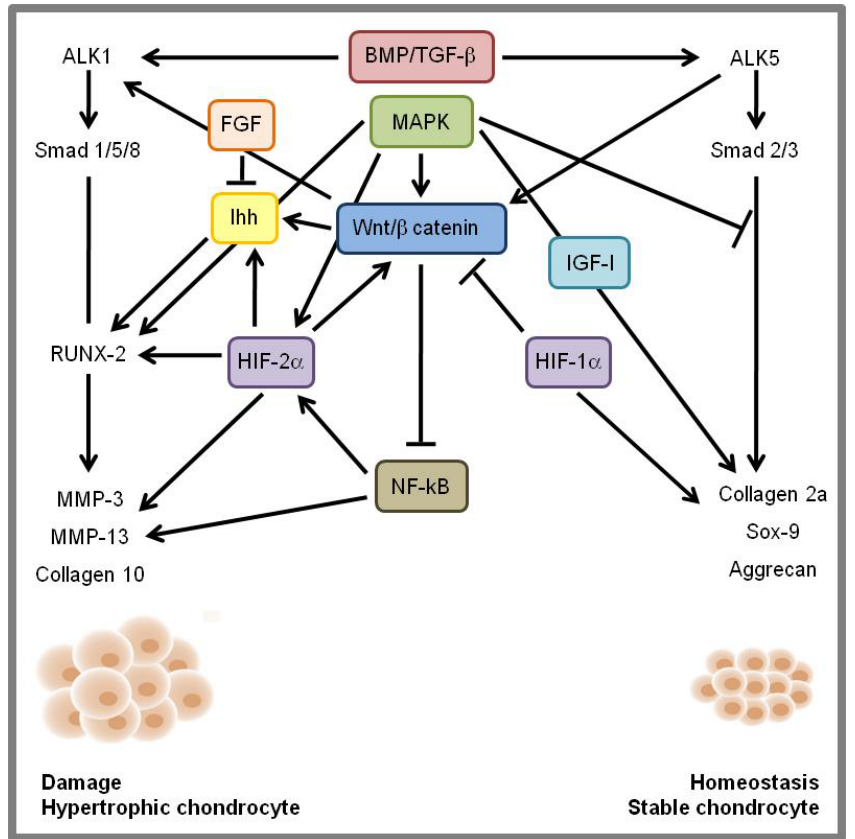
Figure 1. Schematic overview of signaling cross-talk among transforming growth factor- β (TGF- β ), bone morphogenetic proteins (BMPs), hypoxia-related factors (HIF), Wnt/ β -catenin, nuclear factor kappa B (NF- κ B), mitogen-activated protein kinase (MAPK) and Indian hedgehog (Ihh)